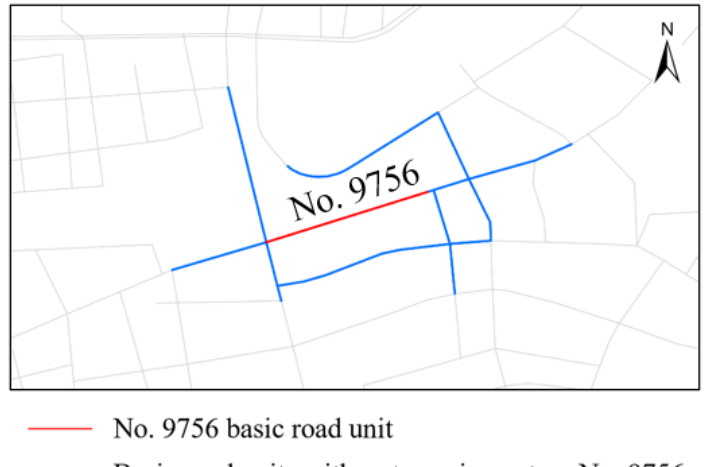
Figure 16. Road network influence subgraph with No. 9756 basic road unit as the core.